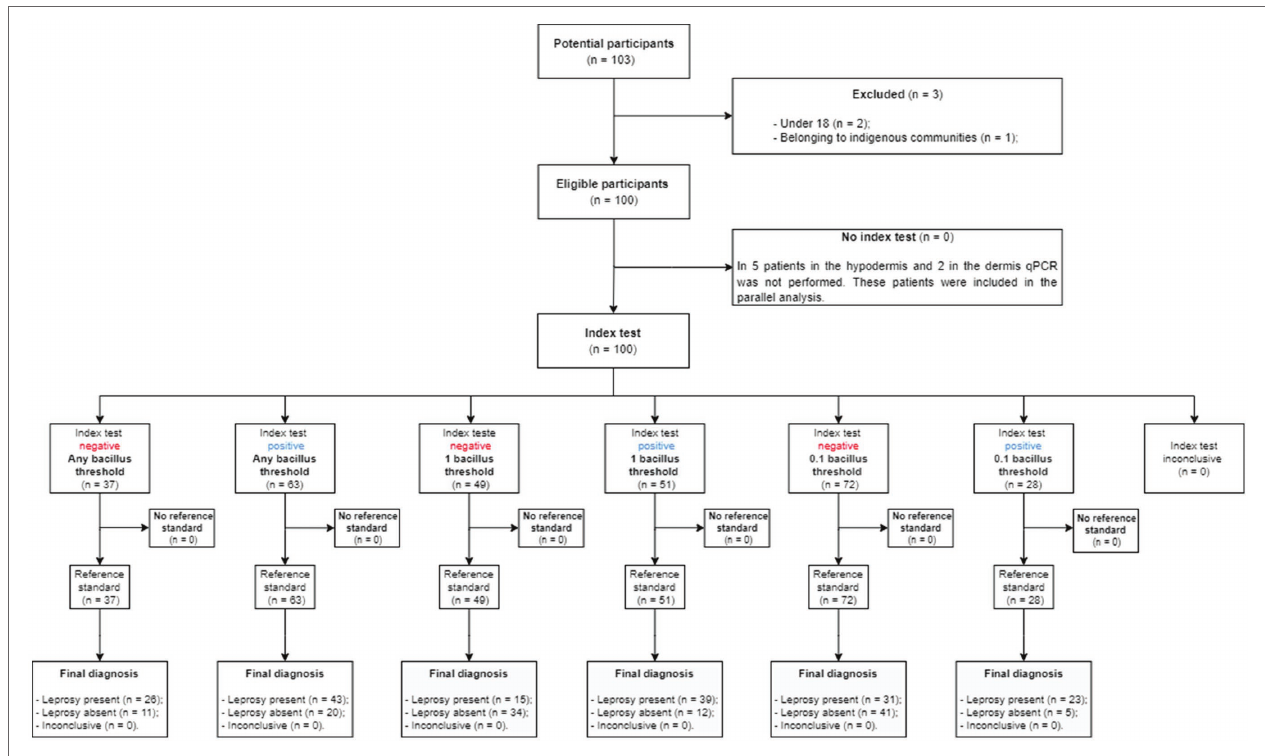
FIGURE 2 | Study diagram of the flow of the participants during the